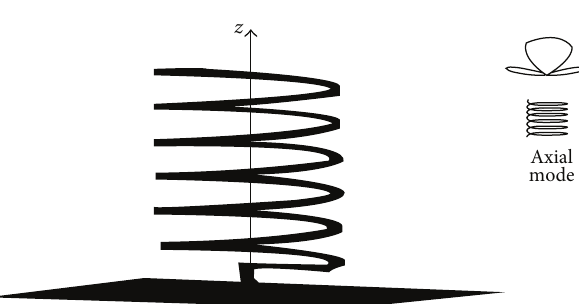
Figure 1: A conventional PIFA.